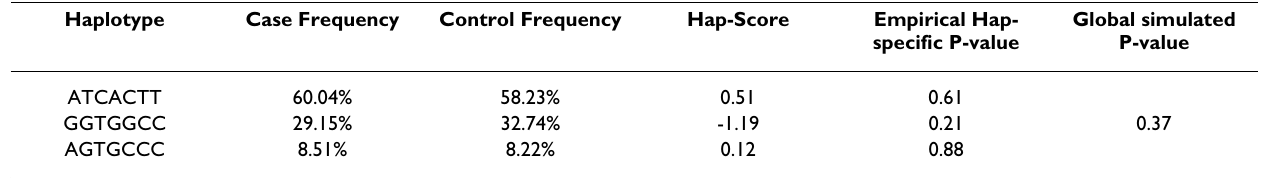
Table 2: Haplotype analysis using HAPLO.SCORE and Dandelion with 7 SNP (rs2425902, rs2425906, rs2425907, rs998422, rs2425911, rs3091904, rs1059217) SLC2A10 haplotypes.